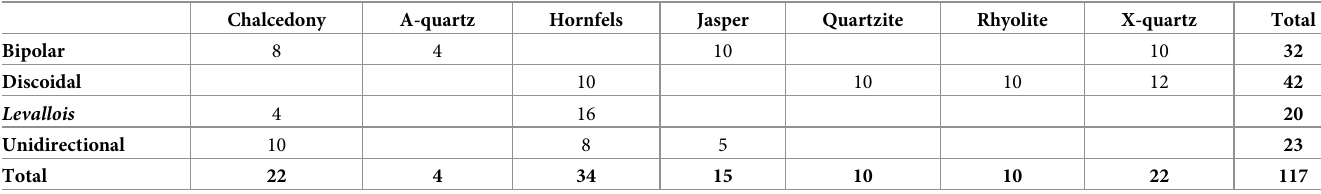
Table 1. Synthesis of the knapping methods and raw materials used in this experiment (A-quartz = Automorphic quartz, X-quartz = Xenomorphic quartz). Chalcedony A-quartz Hornfels Jasper Quartzite Rhyolite X-quartz Total Bipolar Discoidal 10